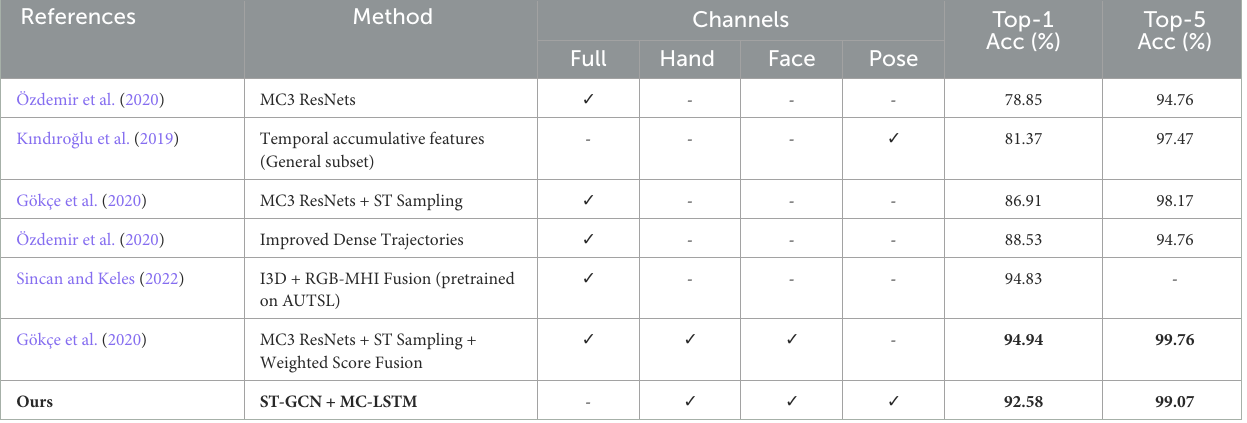
TABLE 3 Comparison with the state-of-the-art results on the BosphorusSign22k dataset.